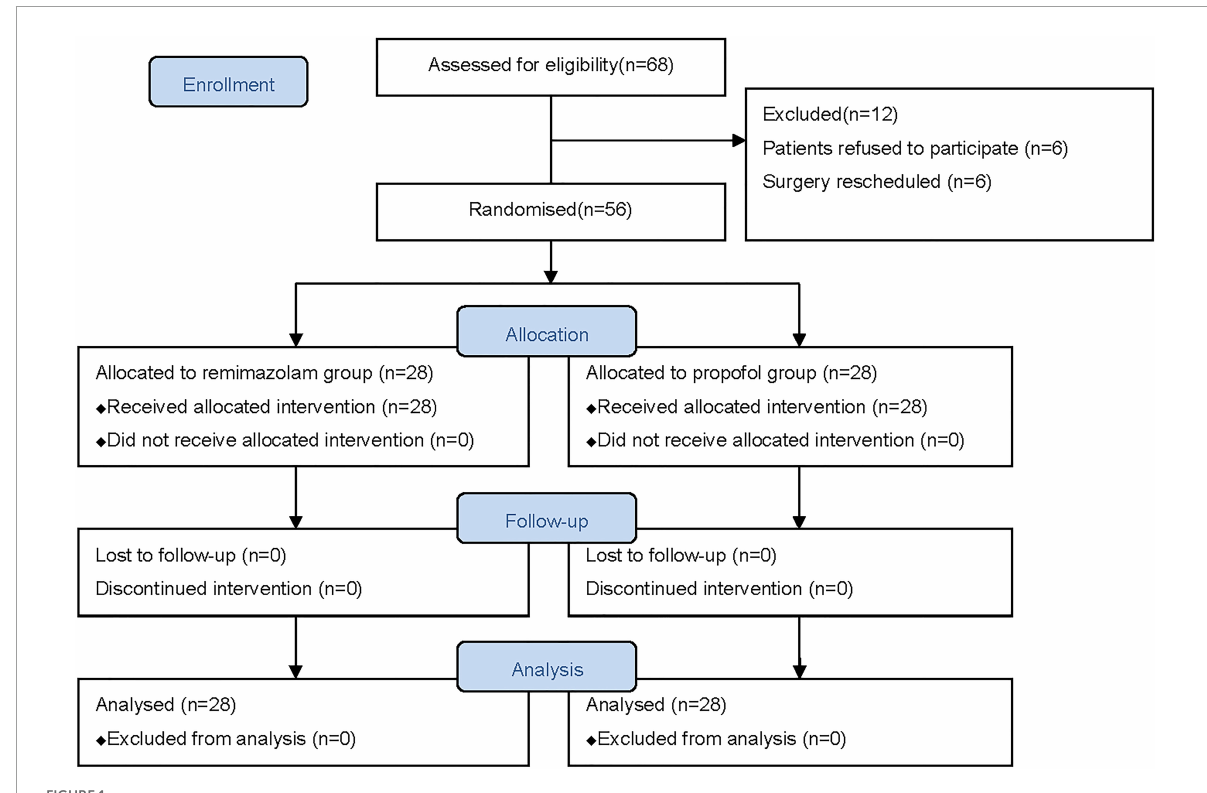
FIGURE1 Flowchart of patients enrolled in the